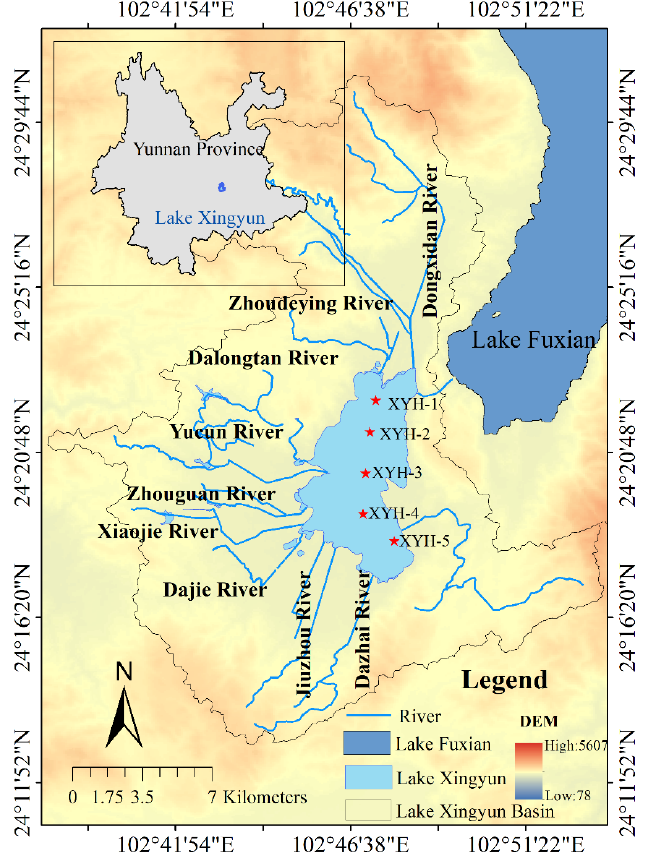
Figure 1. The location of Lake Xingyun and sampling sites.